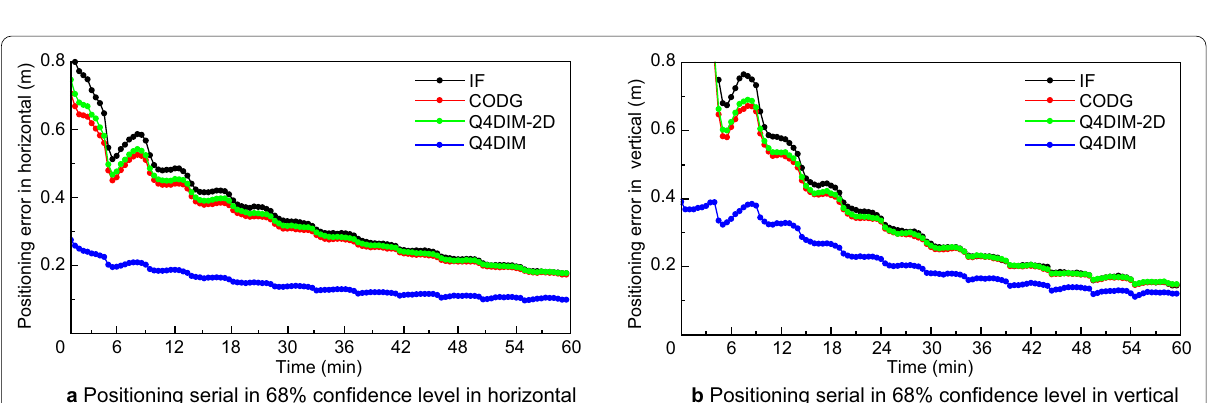
Fig. 12 Double frequency PPP convergence serial for DOY 001–030, 2014, respectively. While for different ionospheric delay processing mode with IF, CODG, Q4DIM‑2D and Q4DIM, the results are denoted in black, red, green, and blue,